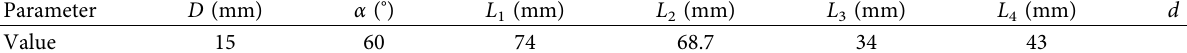
Figure 1: Confguration of improved QHA. (a) Unwrapped model. (b) 3D model. Table 1: Structure parameters of improved QHA.